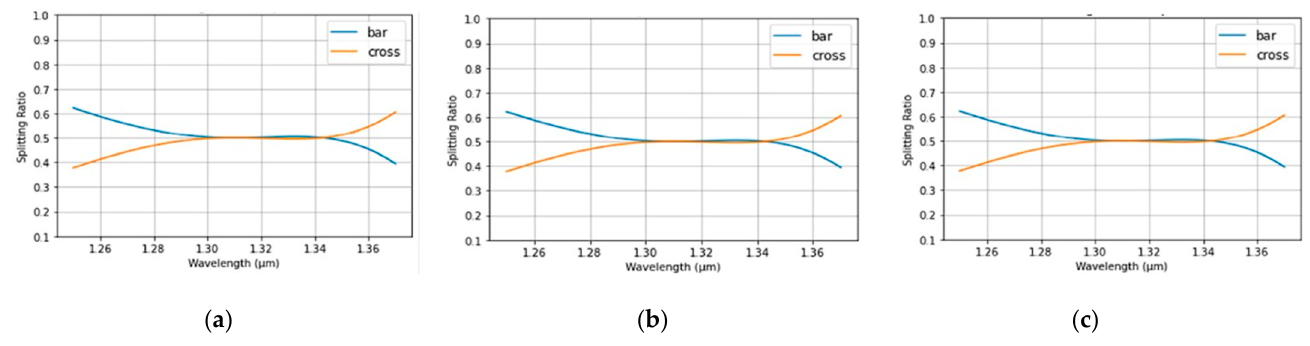
Figure 5. The simulated spectrum response for the bidirectional MZDC ( a ) without the process length shift; ( b ) 10 nm length shift; ( c ) − 10 nm length variation.